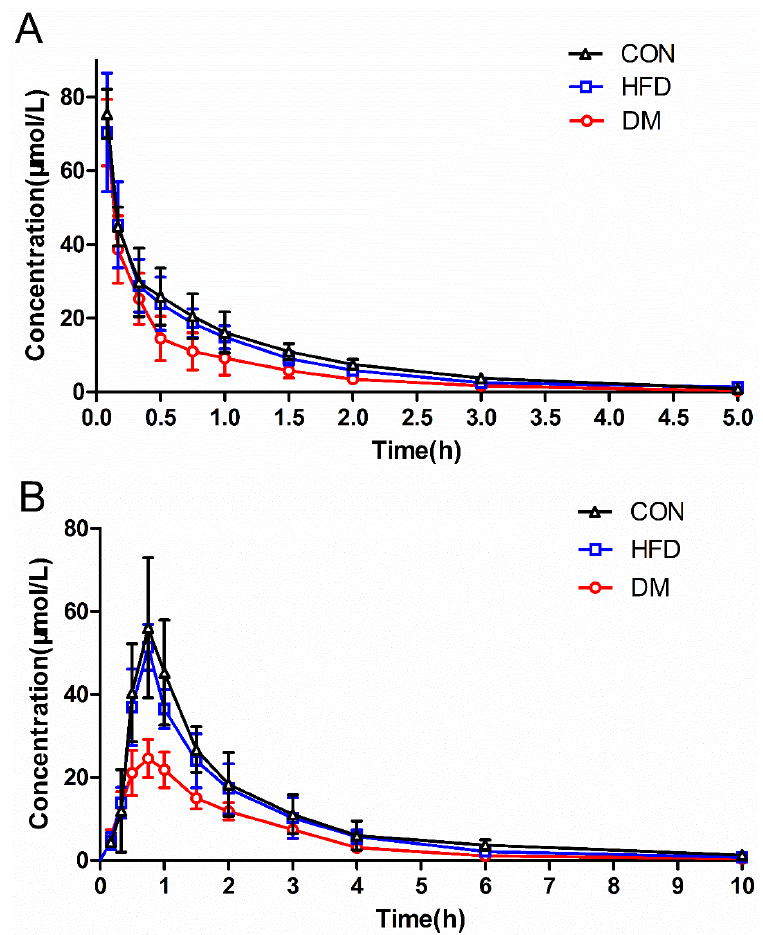
Figure 3. Plasma concentration–time curves for puerarin in rat plasma after intravenous (at 20 mg/kg, A ) and oral administration (at 500 mg/kg, B ) to diabetes mellitus (DM), high-fat diet (HFD), and control (CON) rats. Each point represents the mean ± SD ( n = 7). Table 4. Non-compartmental pharmacokinetic parameters obtained for puerarin after its intravenous administration (20 mg/kg, approximately 48 μ mol/kg) to DM, HFD and CON rats. Pharmacokinetic